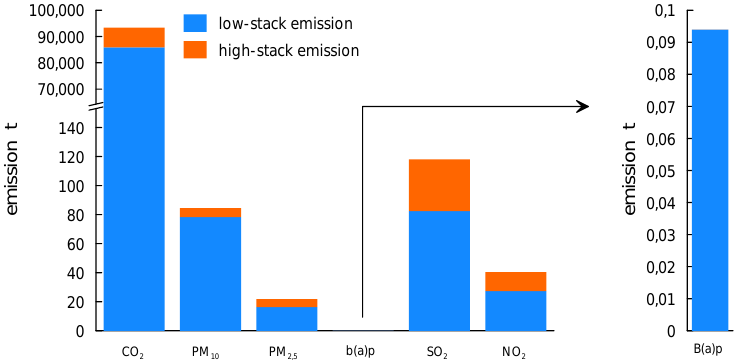
Figure 4. Emissions of pollutants into the atmosphere in the City of Nowa Ruda from combustion of fuels for heating purposes in 2018